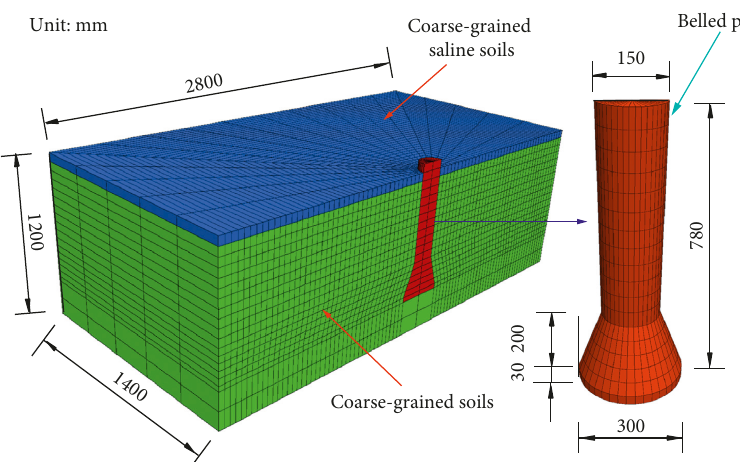
Figure 17: Geometric model in computation.